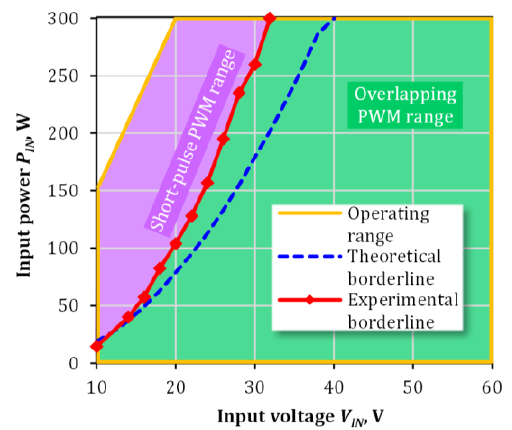
Figure 13. Locations of the experimental and theoretical borderlines describing the transition between the overlapping and the short-pulse PWM schemes employed in the hybrid PWM scheme within the target operating range.